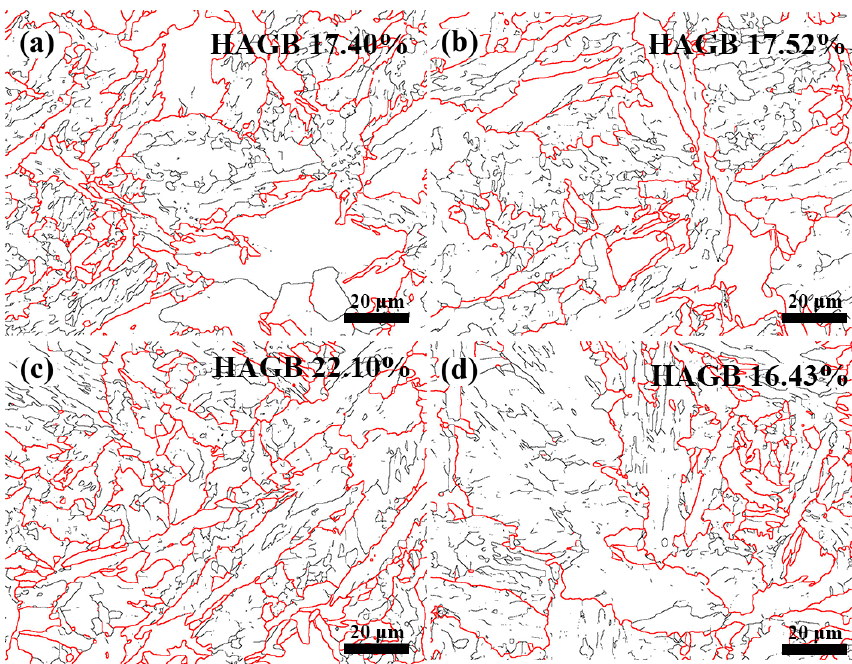
Figure 9. Morphology of the grain boundaries in tested steels. ( a ) #1 (Ce-free); ( b ) #2 (0.014% Ce); ( c ) #3 (0.024% Ce); ( d ) #4 (0.037% Ce). Where the red line refers to the high angle grain boundary with grain misorientation more than 15° and grey line refers to the low angle grain boundary with grain misorientation less than 15°.